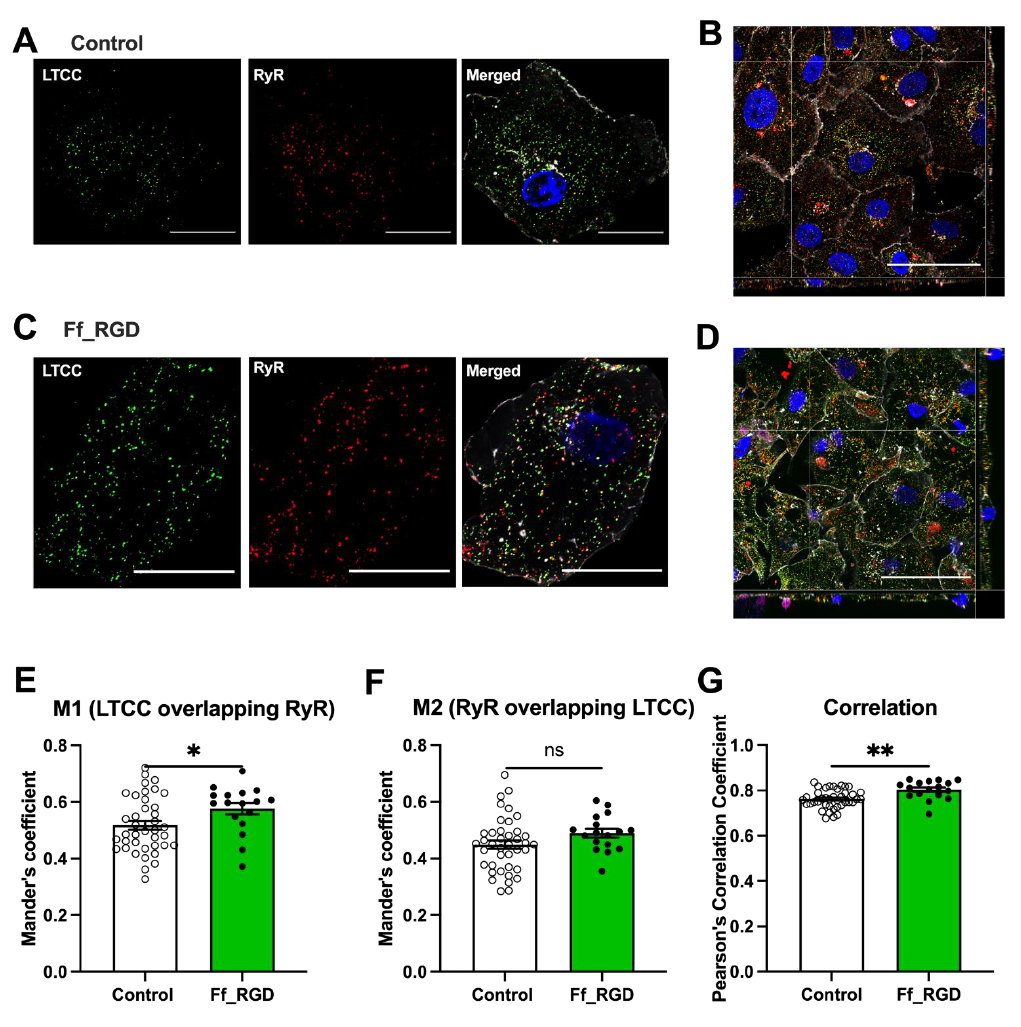
Figure 4. Integrin ligand ff_RGD induced changes in the Ca 2+ cycling ultrastructure. L-type calcium channel (LTCC) subunit CaV1.2 (green) and ryanodine receptor (RyR) 2 (red) were labelled and orthoview z-stack formed with wheat germ agglutinin (WGA) (white) and Hoechst (blue) staining ( A , B ) control and ( C , D ) ff_RGD-treated cardiomyocytes (day 40 – 46 of differentiation). Scale bar for A and 6 = 20 µ m, B and D = 50 µ m. Merged images used to calculate the Mander’s correlation